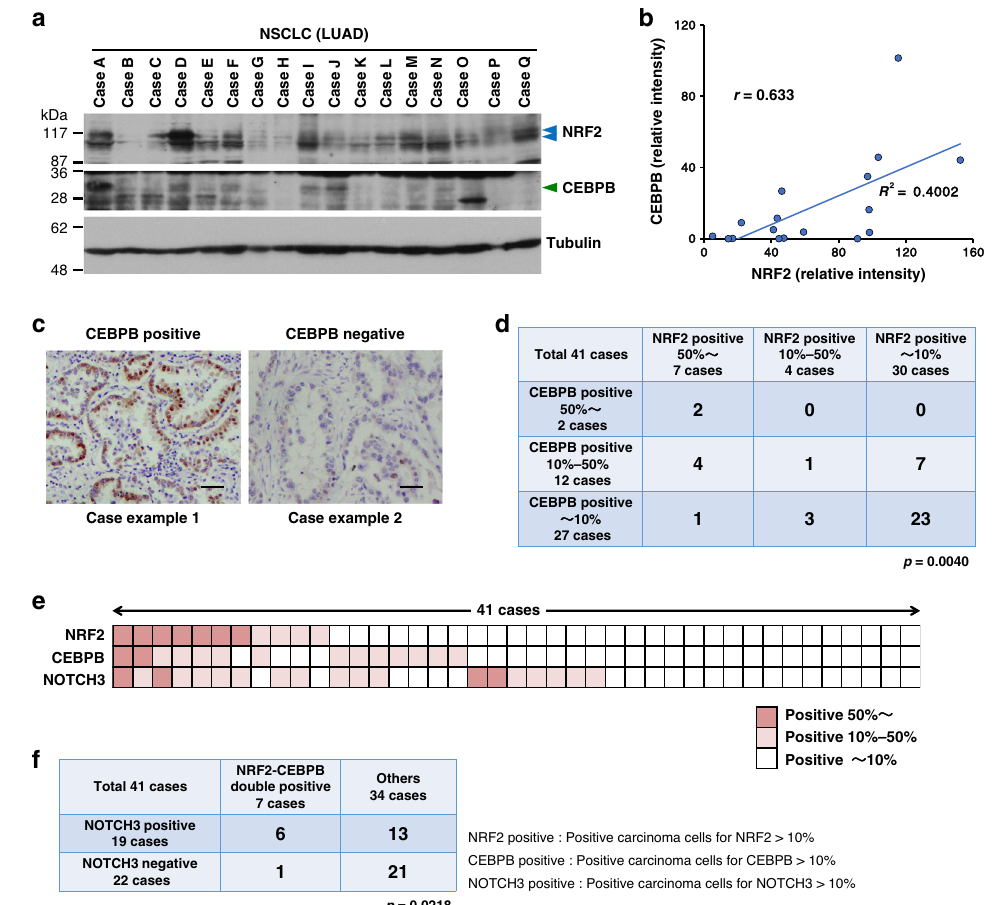
Fig. 7 CEBPB and NRF2 are frequently co-expressed in tumor tissues of lung adenocarcinoma. a Immunoblot analysis of NRF2 and CEBPB in primary LUAD tissues. Blue arrowheads indicate speci fi c bands of NRF2. A green arrowhead indicates the CEBPB isoform that corresponds to the one detected in the immunoprecipitation experiment with the NRF2 antibody shown in Fig. 6c. Tubulin was detected as a loading control. A representative result from two independent experiments is shown. LUAD; lung adenocarcinoma. b . Plots of band intensities of NRF2 and CEBPB shown in a . r : Pearson ’ s correlation coef fi cient, R 2 : R -Squared, p : two-tailed p value. c Immunostaining for CEBPB in LUAD tissues. Representative cases with high and low expressions of CEBPB from two independent experiments are shown. Scale bars correspond to 50 μ m. The same cases are shown in Fig. 2b. d – f Association of NRF2 and CEBPB statuses ( d ), a heatmap of immunoreactivities of NRF2, CEBPB and NOTCH3 ( e ) and association of NRF2/CEBPB and NOTCH3 statuses ( f ) of the 41 lung adenocarcinoma cases. The Chi-square test was conducted to determine statistical signi fi cance ( d , f ). p = 0.0040 ( d ), p = 0.0218 ( f